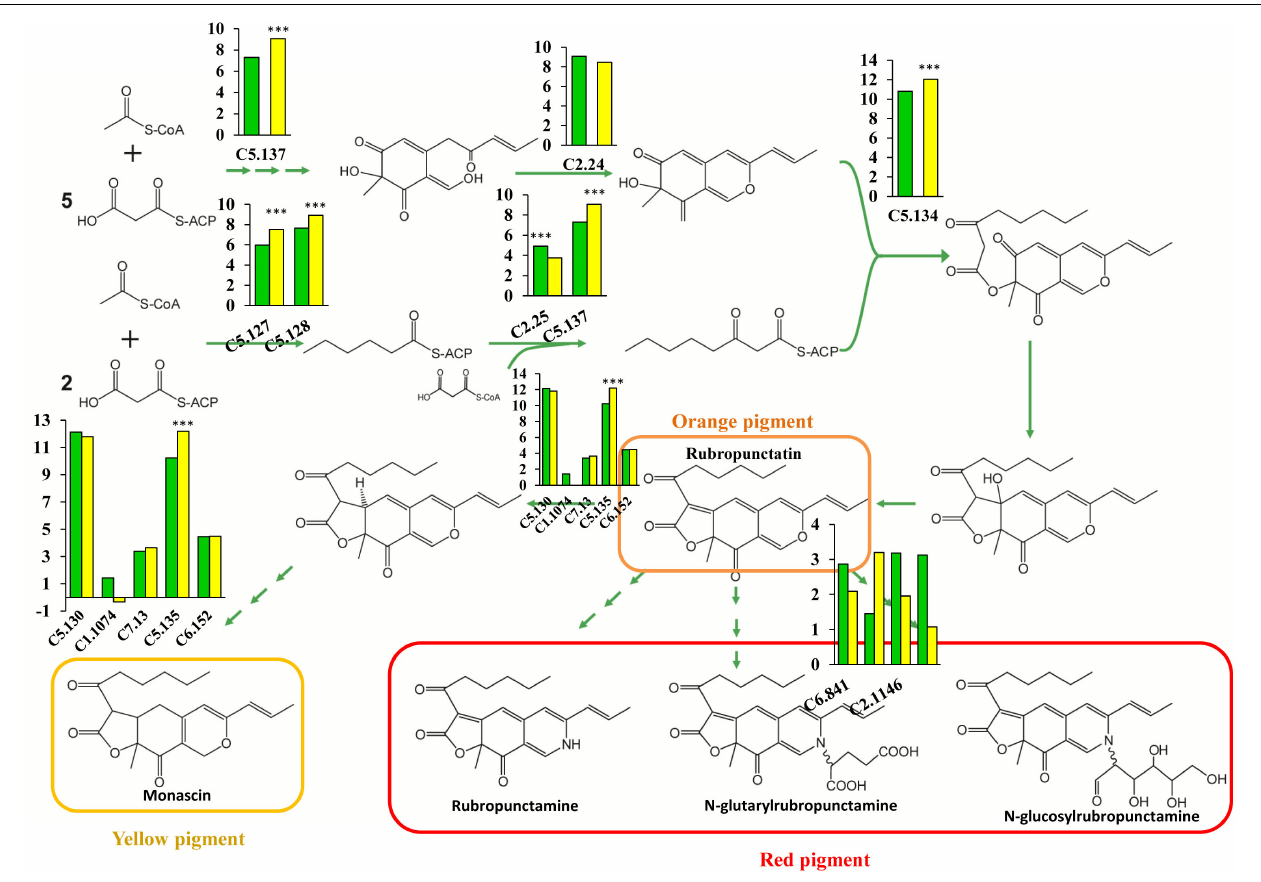
FIGURE 6 | Schematic of pigment biosynthesis pathways in M. purpureus , including pathways for orange pigment (rubropunctatin), yellow pigment (monascin), red pigment (rubropunctamine), and water-soluble pigments. The histogram depicts the gene expression levels in the YY-1 (green) and winter (yellow) strains. The y -axis represents log2(RPKM), and ∗∗∗ denotes a P adj value <